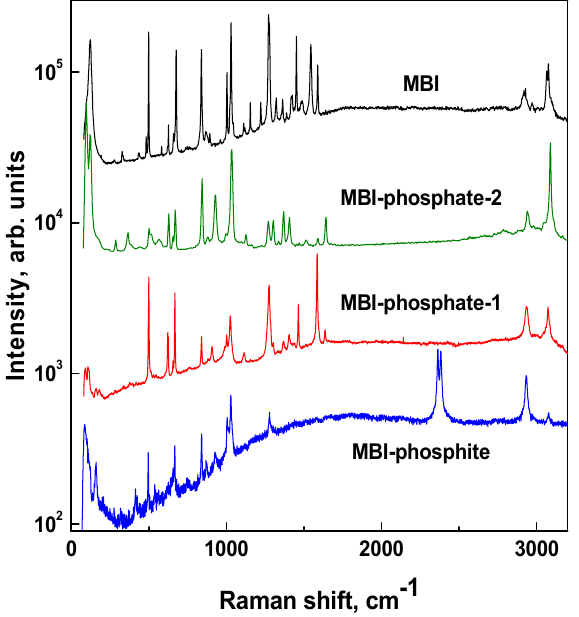
Figure 8. Raman spectra of MBI, MBI-phosphate-1, MBI-phosphate-2 single crystals, and MBI-phosphite powder. For convenience, the spectra are shifted along the vertical axis. The intensity of scattered light is in logarithmic scale.